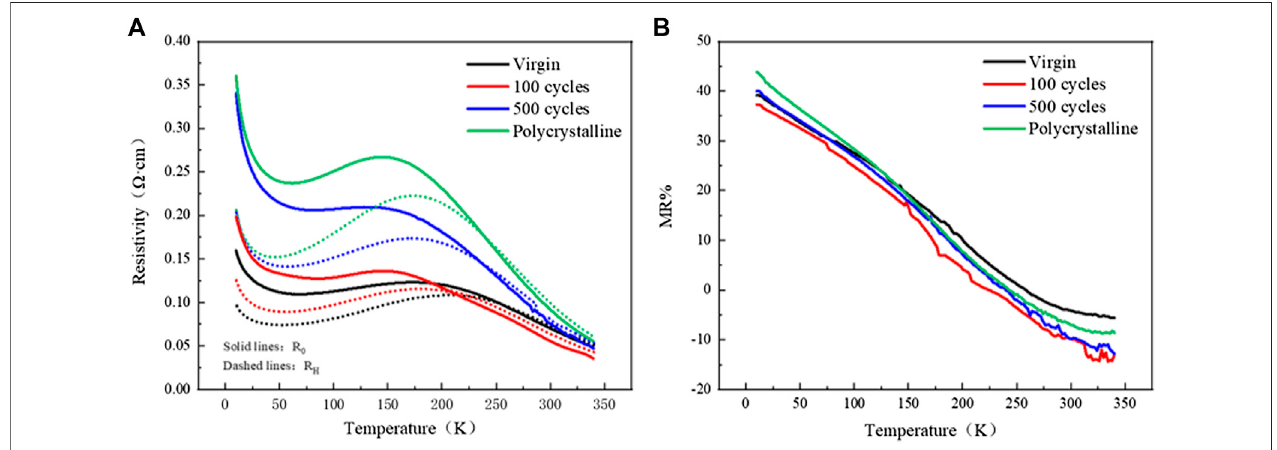
FIGURE4|(A) R-Tcurves(withamagnetic fi eldofzeroor1 T)and (B) temperaturedependenceofMRfortexturedLSMO:ZnO fi lmsunderdifferentbendingcycles (virgin, 100, and 500